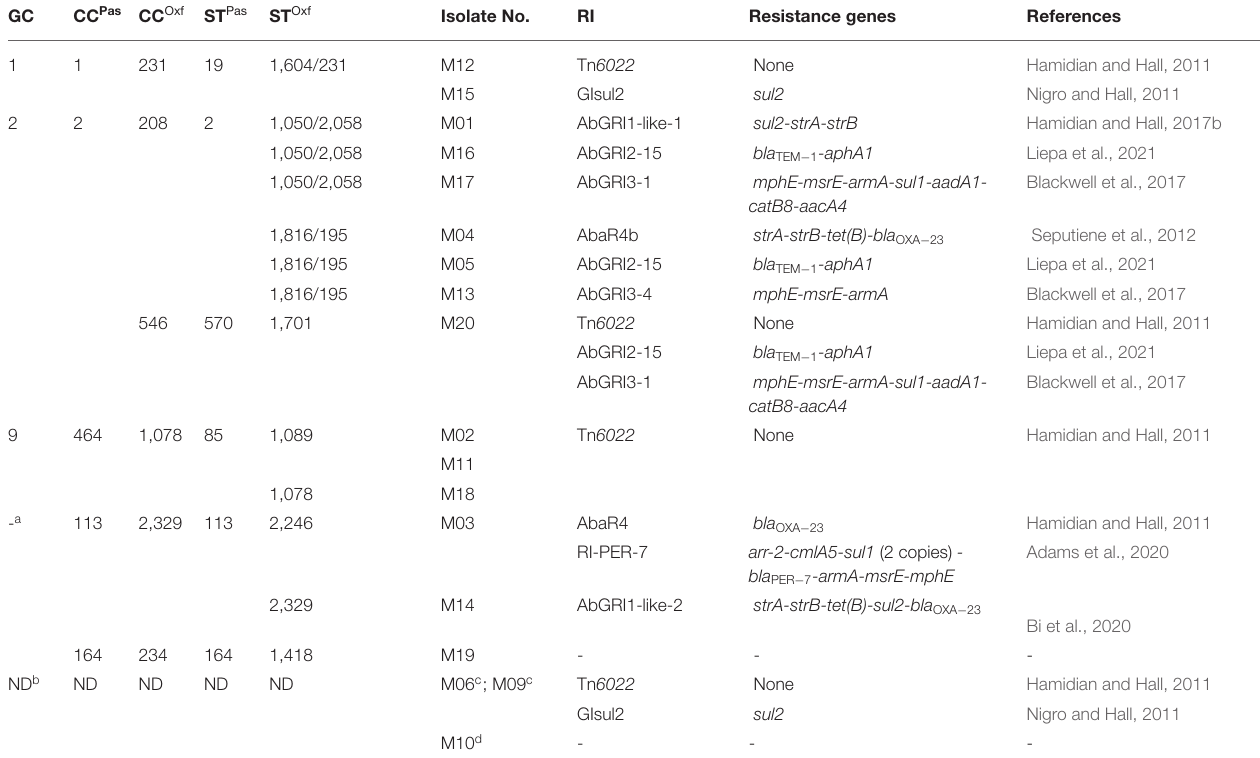
TABLE 3 | Correlation between genomic resistance islands and